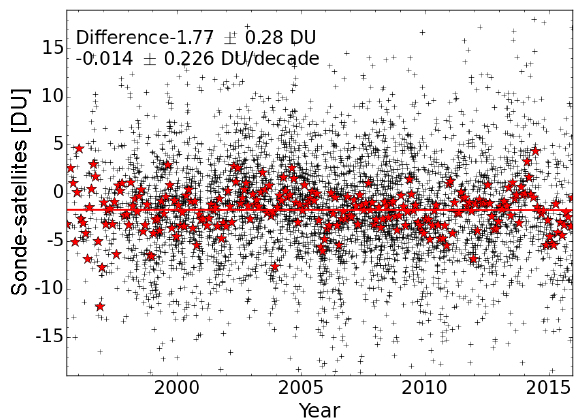
Figure 6. Differences between sondes and the merged data prod- uct. The black crosses indicate the difference between the individual sounding and the collocated satellite observation, the red asterisks show the respective monthly mean and the line shows the fit